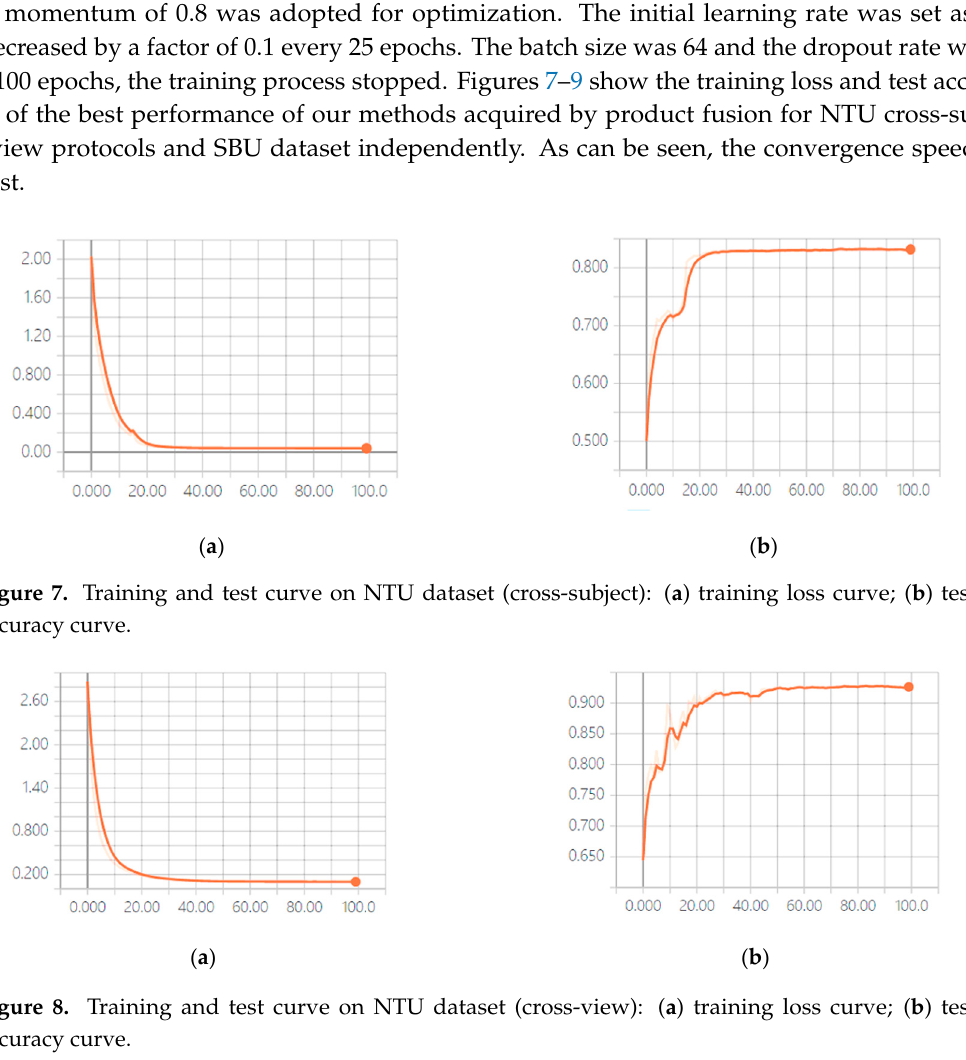
Figure 9. Training and test curve on SBU dataset: ( a ) training loss curve; ( b ) test accuracy curve.